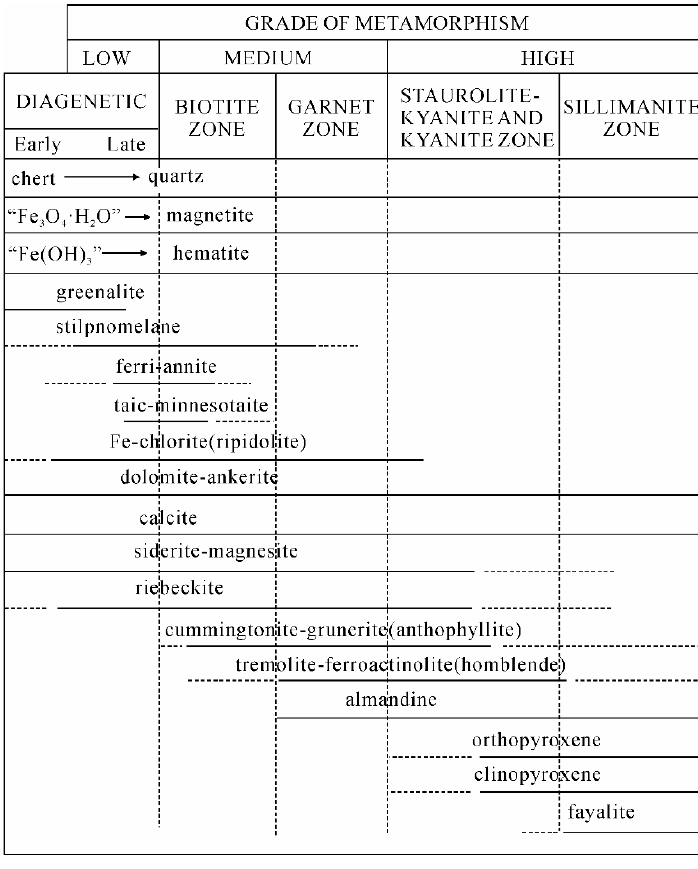
Figure 4. Relative stabilities of minerals in metamorphosed BIF (modified after [7]). Full line express common stability fi eld, and dashed line express possible stabilities of minerals.